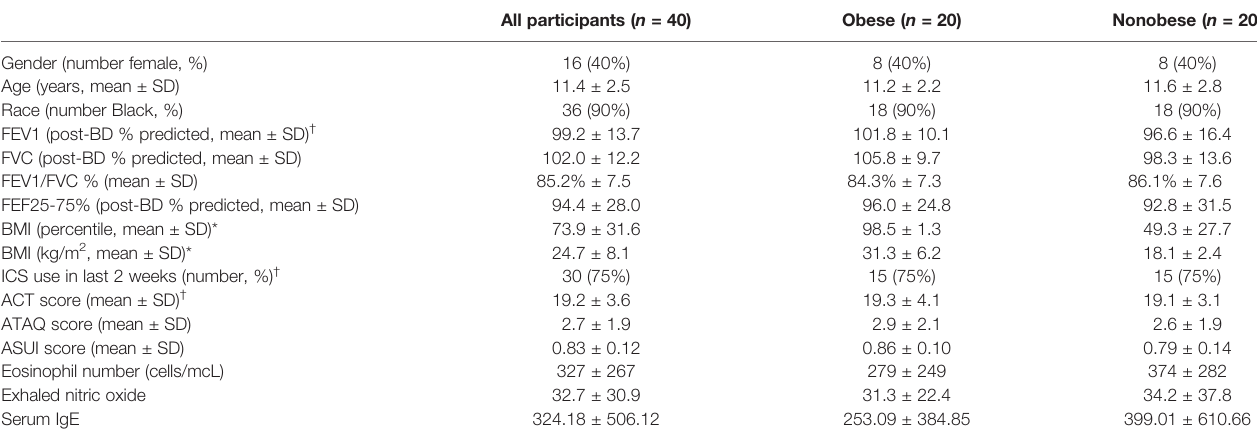
TABLE 1 | Participant